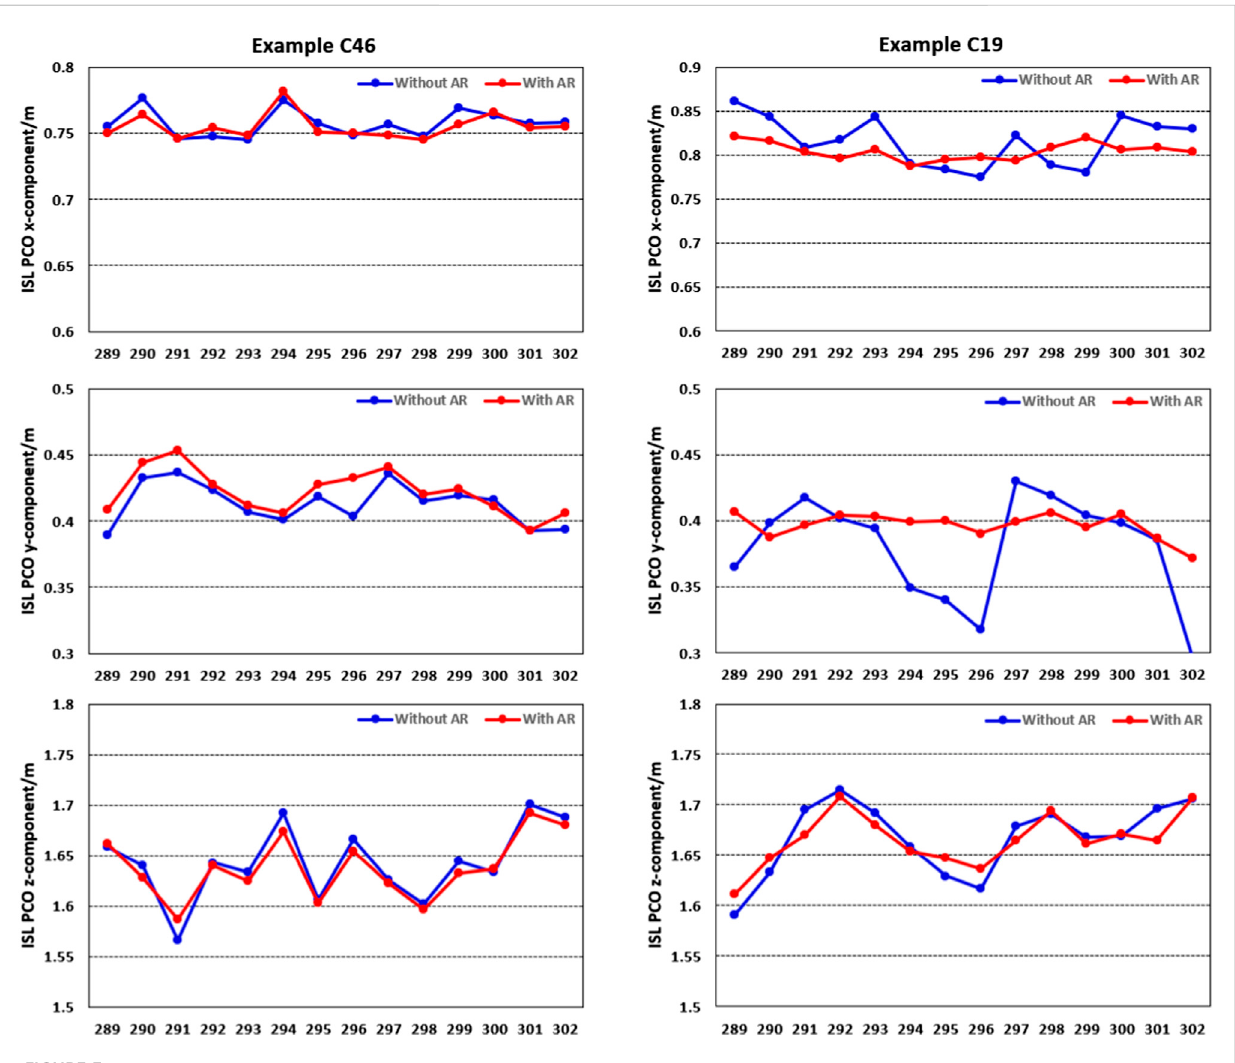
FIGURE 3 Daily estimated ISL PCOs in the x-component, y-component, and z-component with and without ambiguity resolution, respectively, for C46 and C19 during 14